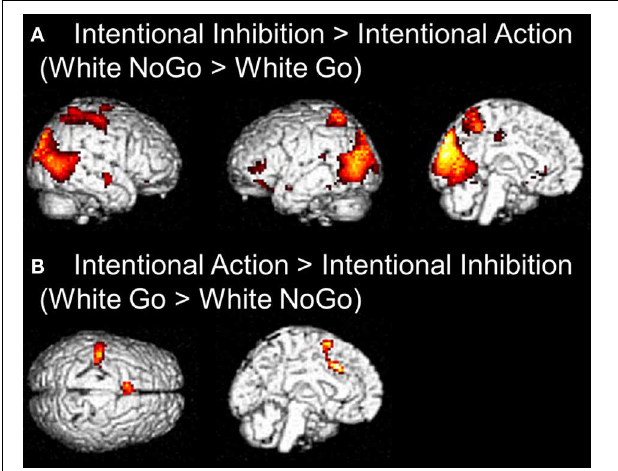
FIGURE 4 | (A) Whole brain contrast showing activation related to intentional inhibition decision outcome (White NoGo > White Go)